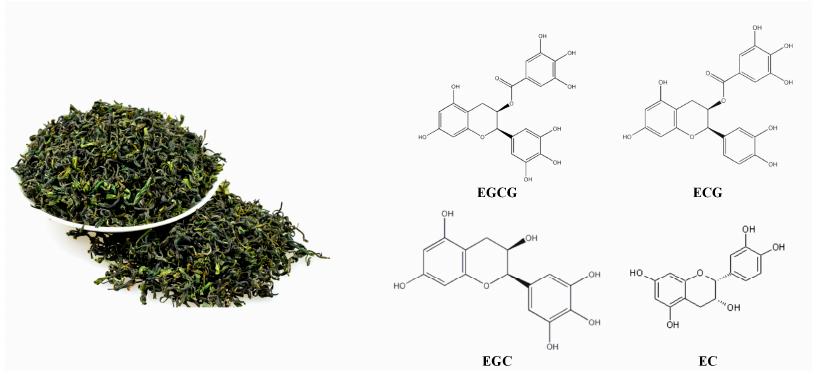
Figure 1. Green tea and structures of major components (EGCG, ECG, EGC, and EG).